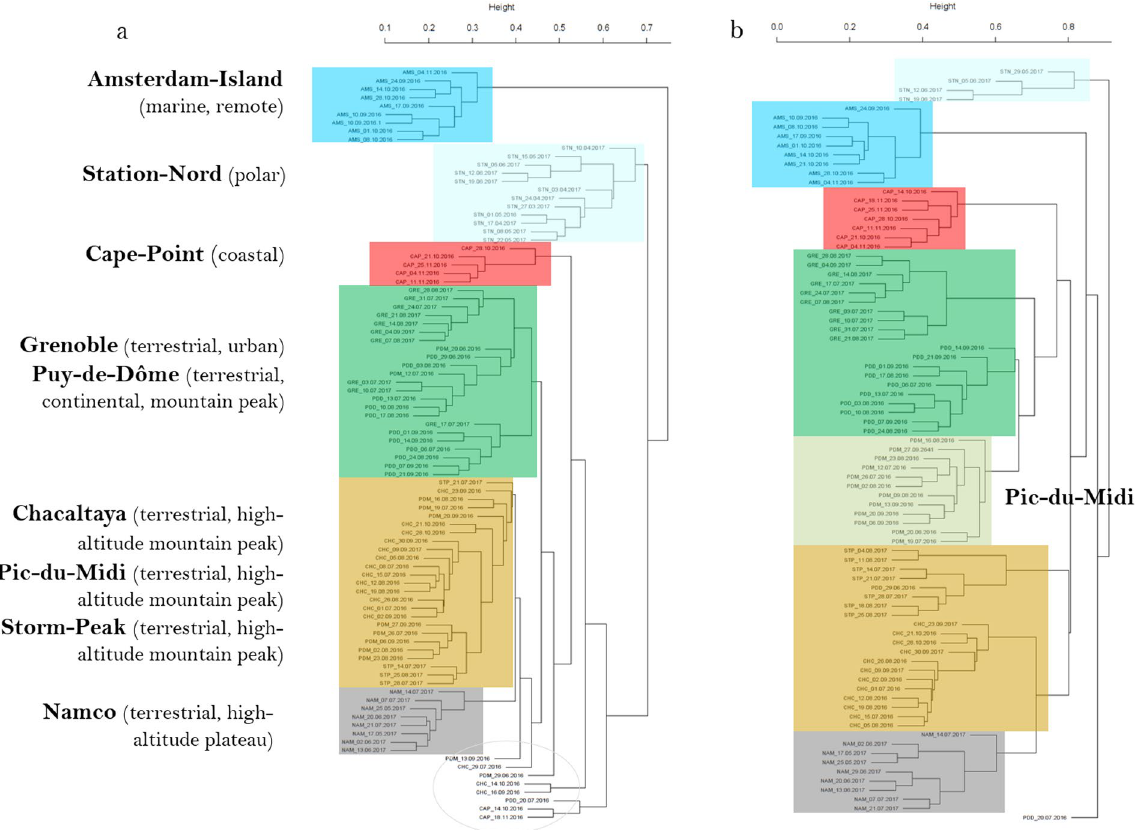
Figure 3. Hierarchical cluster analysis (average method) of the Bray-Curtis dissimilarity matrices based on the ( a ) V3-V4 region of the 16S rRNA gene (genus level) and ( b ) ITS region (species level). Colored rectangles correspond to samples of the same site or group of sites stated beside the rectangles. Outlier samples (samples which were outside their expected group) are circled in grey. Samples are named as follows: site_date.of.